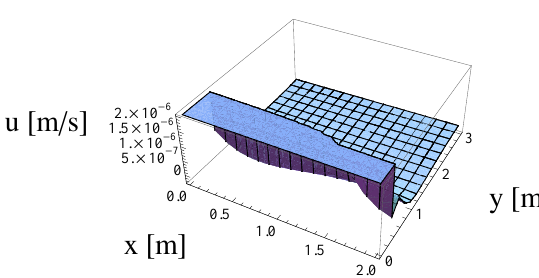
Figure 10: Variation of the velocity component u from Eq. (4) for λ = 0.1 , S = −0.3 , for hydraulic oil at a temperature of 40 ◦ C .